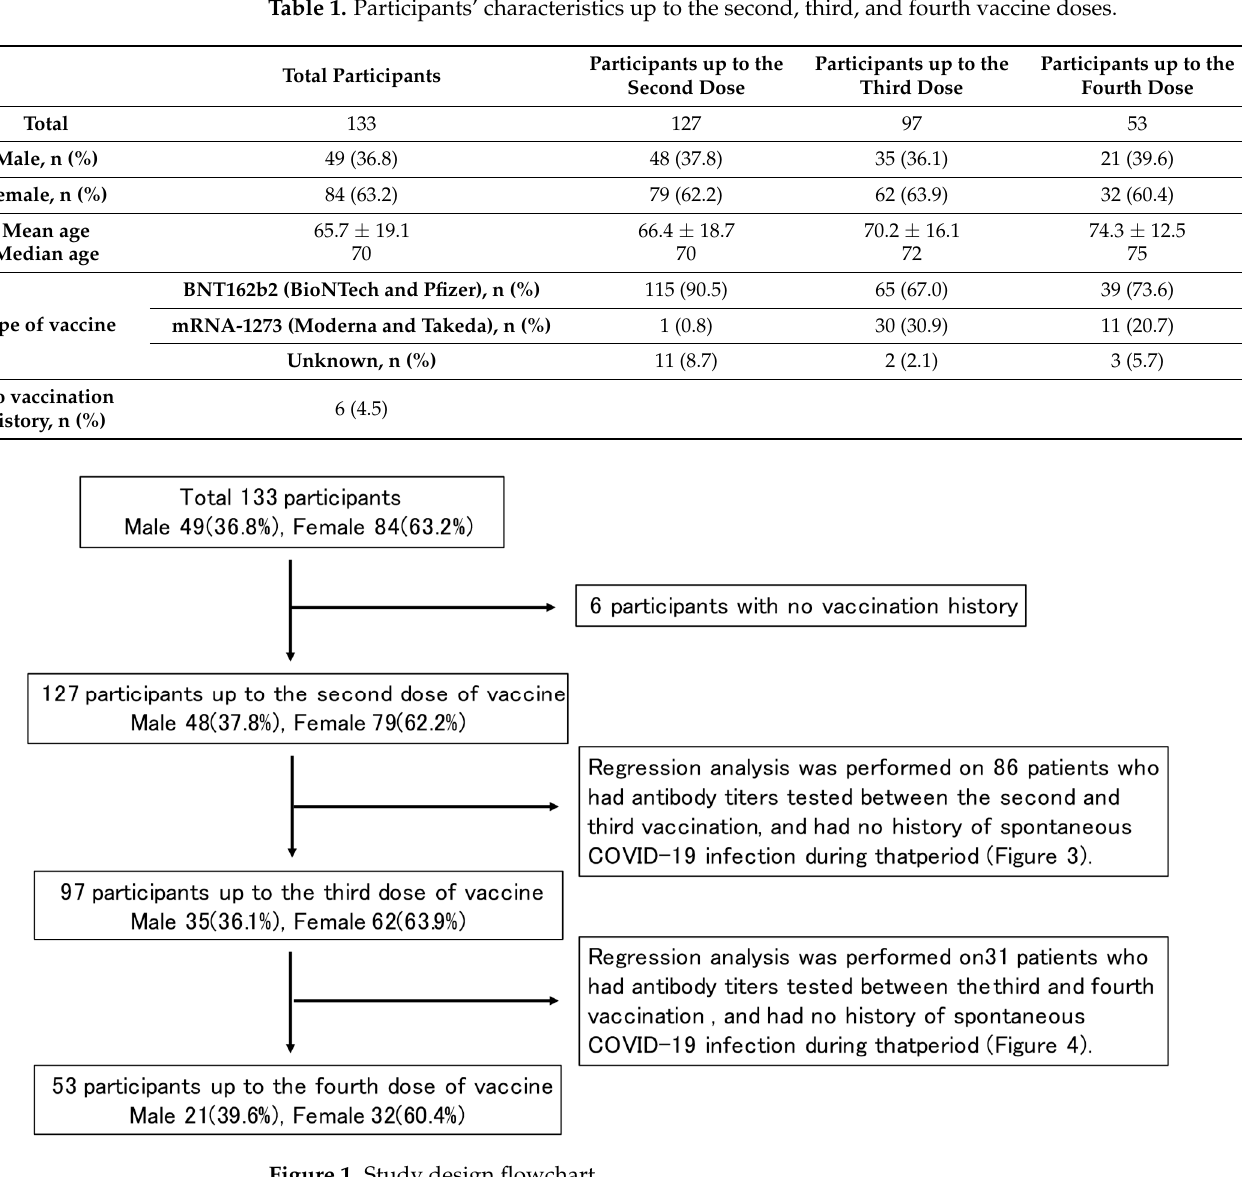
Figure 1. Study design fl owchart.